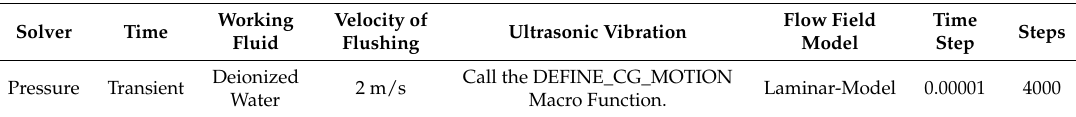
Table 1. Simulation parameters set in Fluent.